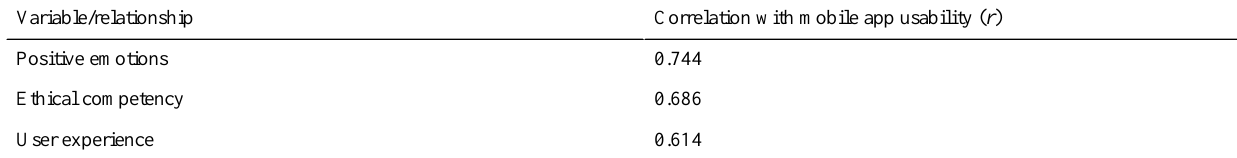
Table 1. Correlation coefficients for positive emotions, ethical competency, and user experience.